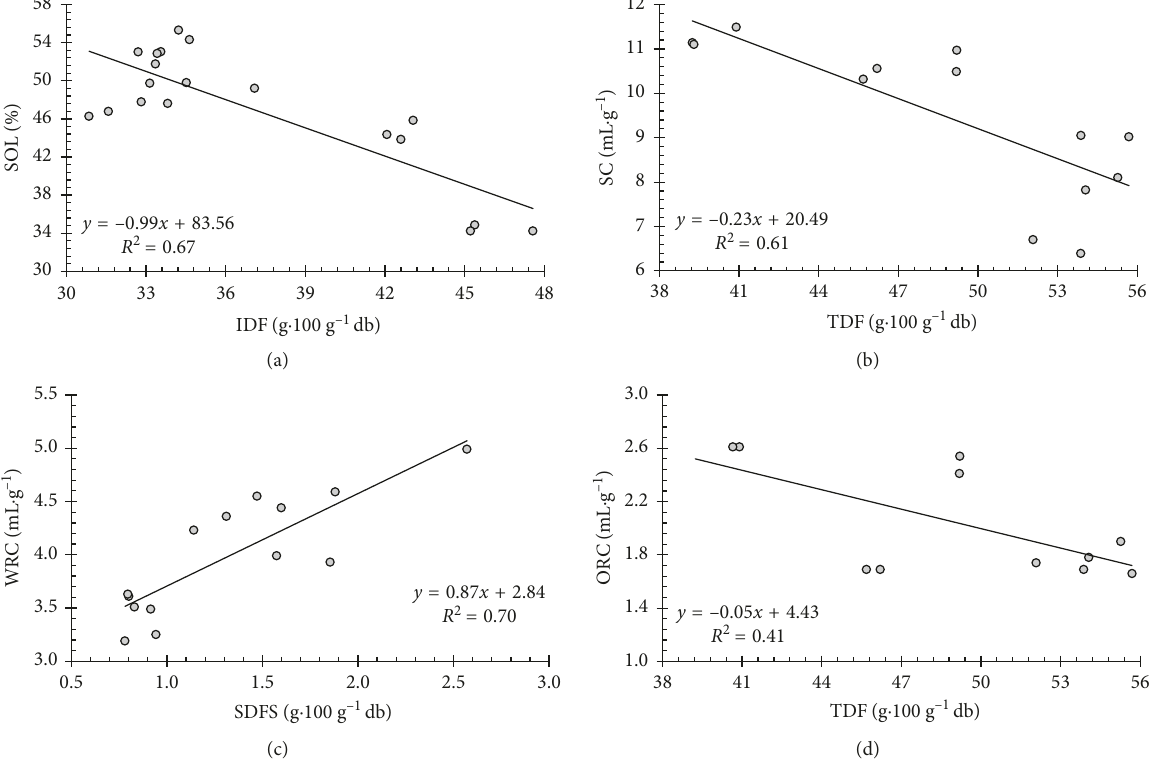
Figure 1: Correlation among physicochemical properties and different dietary fibre fractions: (a) solubility (SOL) and IDF, (b) swelling capacity (SC) and TDF, (c) water retention capacity (WRC) and SDFS, and (d) oil retention capacity (ORC) and TDF of DFC from fruit peels obtained by freeze-drying and convective hot air-drying. TDF: total dietary fibre; IDF: insoluble dietary fibre; SDFS: low-molecular weight soluble dietary